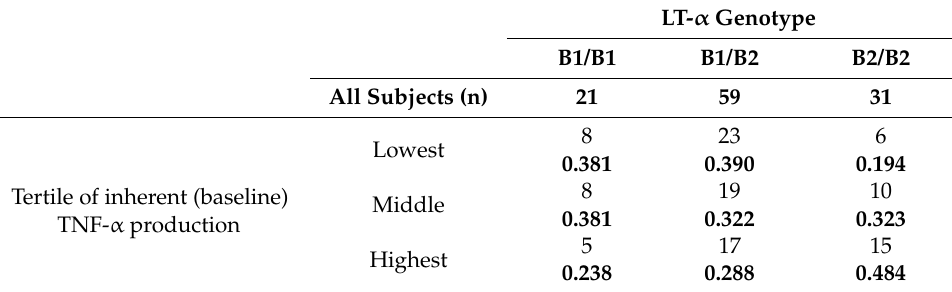
Table 2. Proportion of genotype in each tertile of inherent (baseline) TNF- α production.